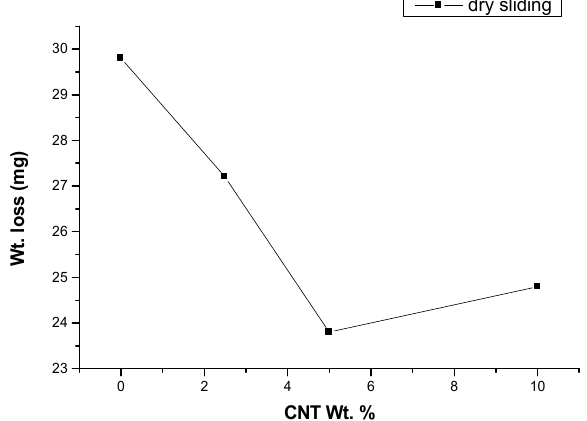
Figure 2. Wt. loss of CNT filled GFRP (wt.% 0, 2.5, 5 and 10) at 3.14 m/s, 120 N load and 2828 m sliding distance under dry sliding environment.